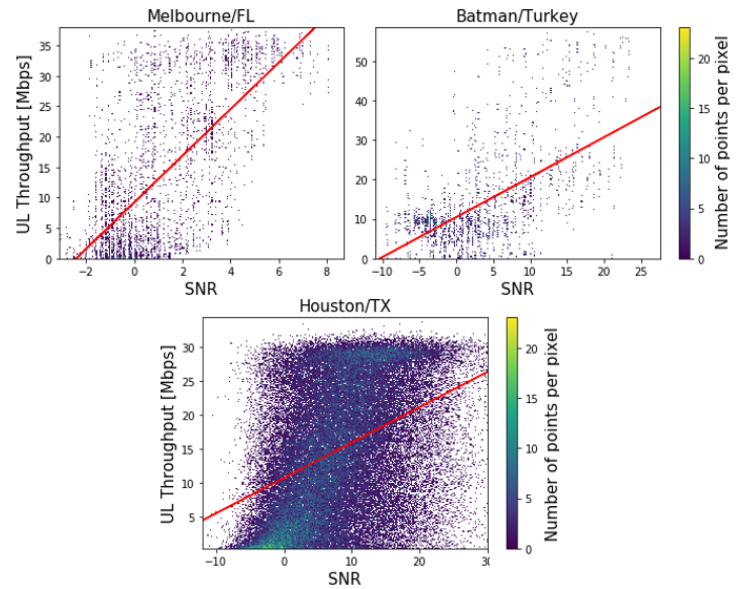
Figure 9. Scatter plot of SNR and UL throughput. Measurements with low UL throughput are concentrated in the low SNR region, and the measurements with high UL throughput are grouped around higher SNR